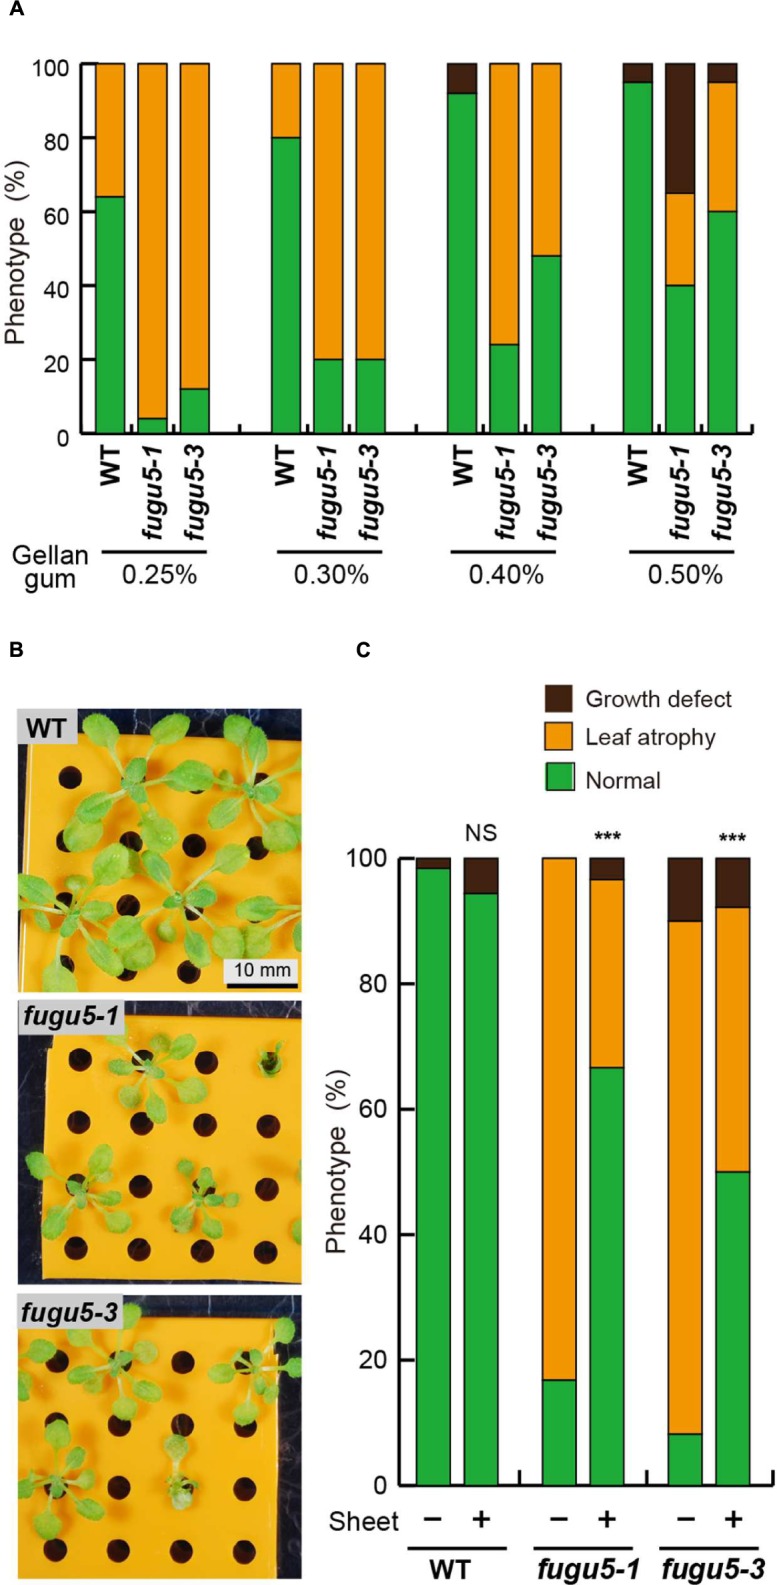
Physical contact with the MGRL culture medium enhances leaf atrophy.
(A) WT and fugu5 mutants were grown on MGRL plates with the indicated concentrations of gellan gum. The phenotypic distribution for each line is shown (n = 25). (B) WT and fugu5 mutants were grown on MGRL plates with 0.4% gellan gum, which were set with a porous plastic sheet to prevent direct contact of leaves with the culture medium. (C) The frequencies of three categories of phenotype for each line grown on MGRL culture medium with (+) or without (-) the sheet. Asterisks indicate significant differences at ∗∗∗P < 0.001 compared with plants grown on MGRL plates without a plastic sheet [prop.test: R ver. 3.1.2 (R Core Team, 2014)] (n = 60). NS, not significant.